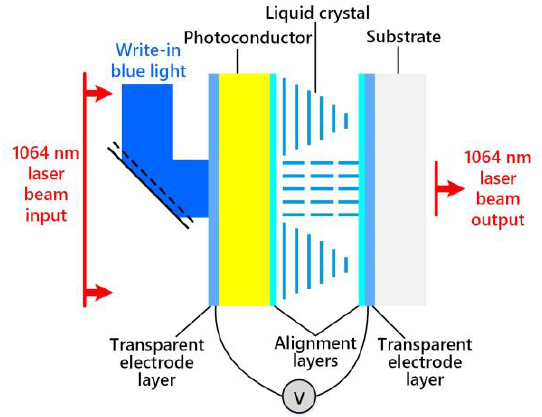
Figure 2. Schematic diagram of the OASLM.